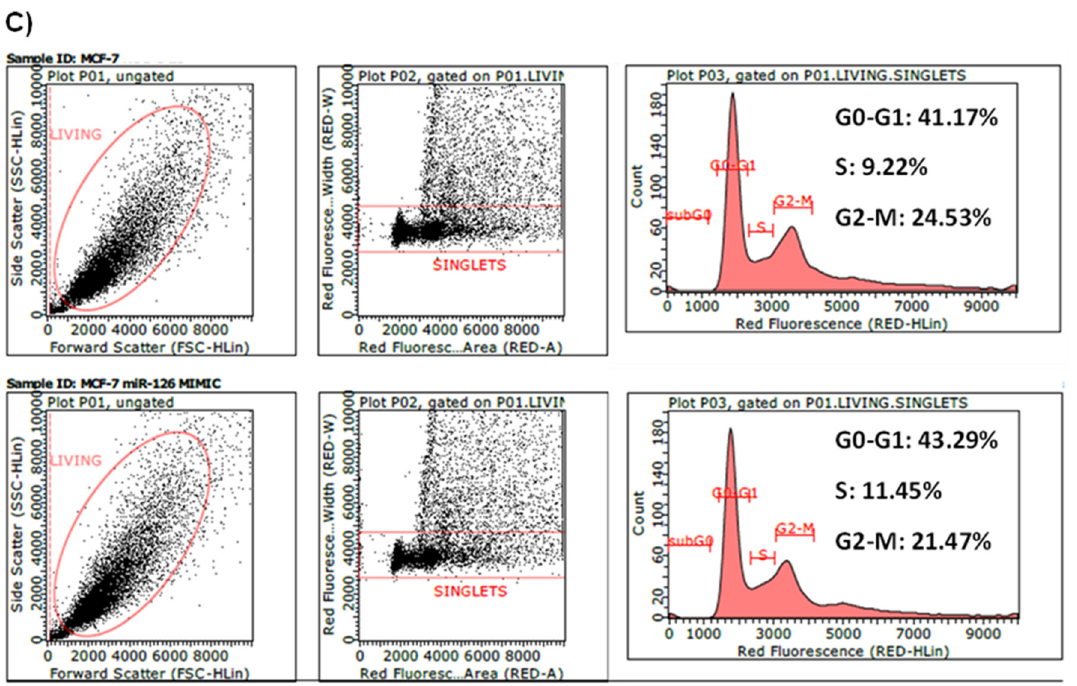
Figure 3. Effect of miR-126 on cell proliferation and cell cycle progression. ( A ): Proliferation of miR-126 mimic compared to NC-transfected cells by MTT assay at 48 and 72 h post transfection ( n = 3). ( B ): Cell Cycle Analysis of the transfected cells by PI staining at 24 h ( n = 3) and 48 h ( n = 3) post transfection. ( C ): Representative figure of the flow cytometric analysis of the cell cycle 24 h post transfection. Error bars represent SEM. * denotes p < 0.05.